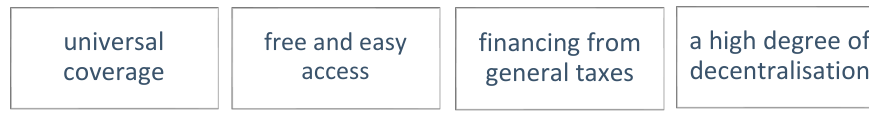
Figure 7. Common features of Nordic healthcare systems [42].